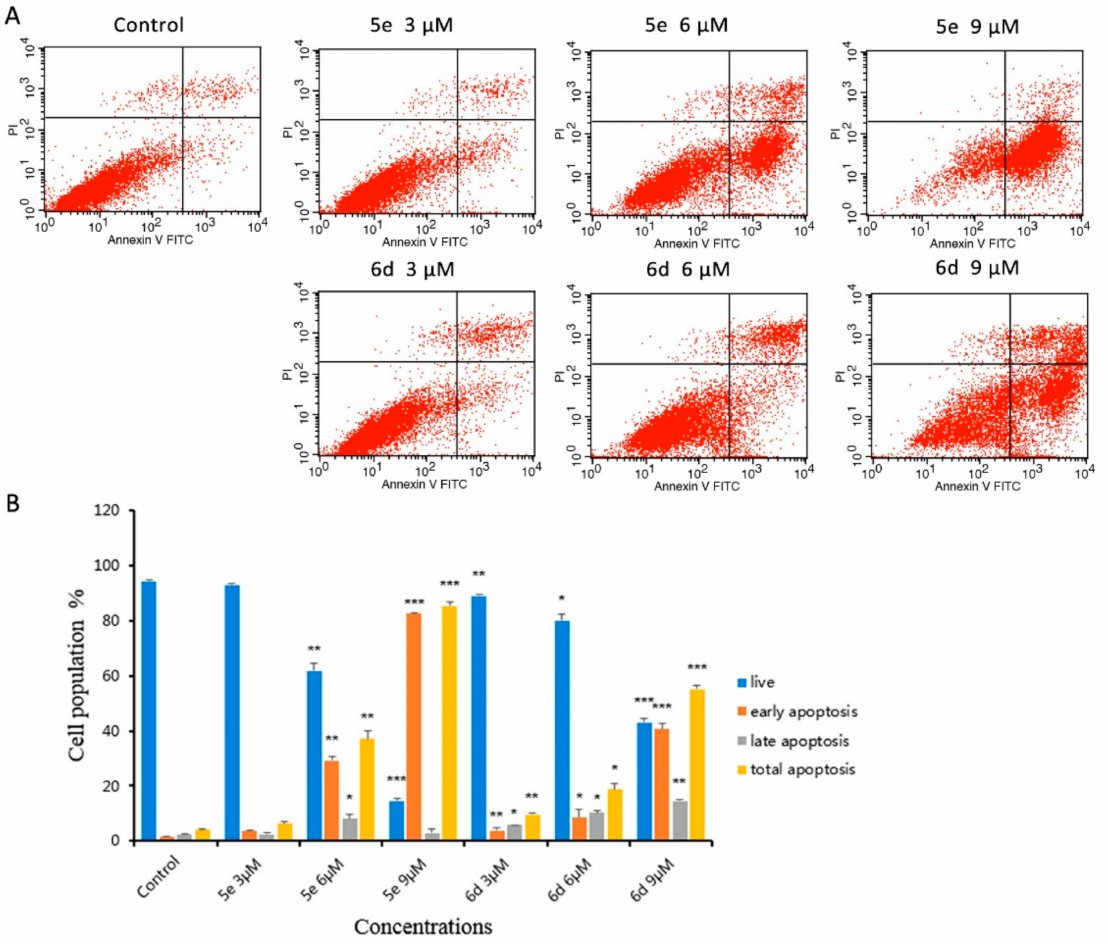
Figure 4. Apoptosis in HepG2 cells by treatment with 5e and 6d : ( A ) HepG2 cells were incubated with di ff erent concentrations of 5e and 6d for 24 h and the cells were stained with annexin V-FITC and PI, followed by flow cytometry analysis. ( B ) Quantitative population analysis of annexin V-FITC / PI staining, presented as mean ± SD of three individual experiments, * p < 0.05, ** p < 0.01, *** p < 0.001 vs control